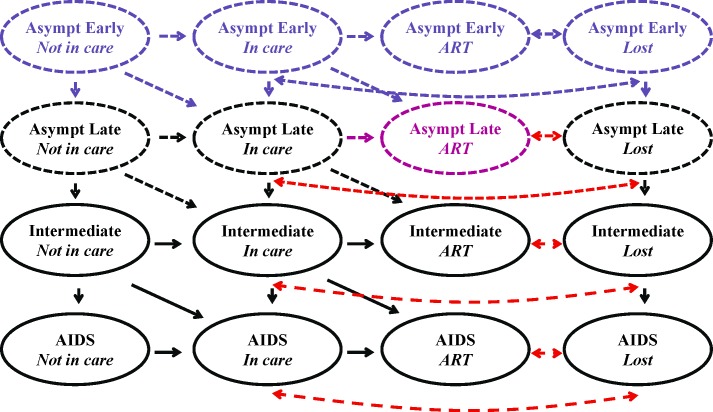
Schematic of revisions to the HIV Policy Model.Shown is a simplified schematic of the HIV Policy Model. Each oval represents a main health state and the arrows represent transitions between health states. Dotted lines reflect new health states or transition probabilities, while colors indicate the implemented model revision. Red represents the Re-entry into Care revision, purple the Universal ART revision, and blue the Guideline-based ART revision. Death from AIDS- or non-AIDS-related causes is not shown.